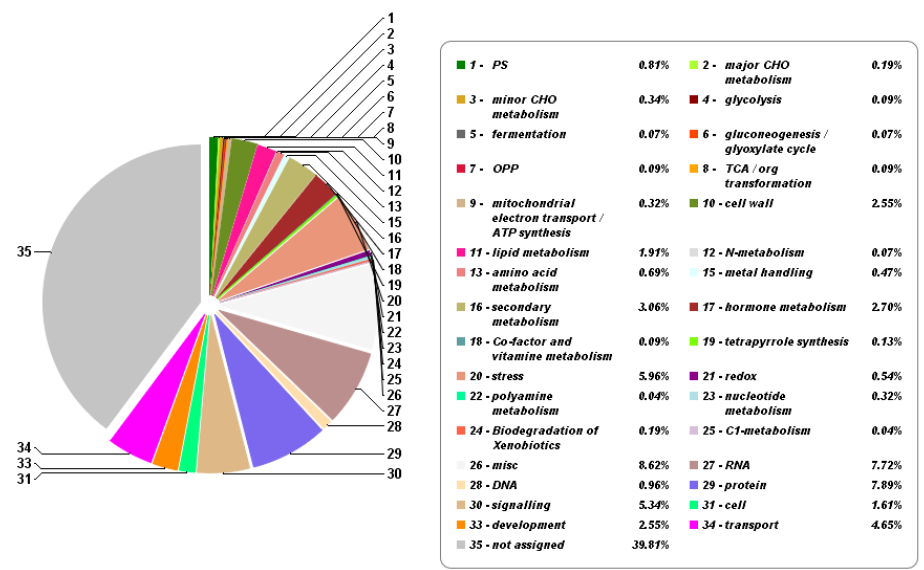
Figure 4. Functional categories of DEGs using MapMan 5.0 with default parameters. The numbers 1-34 in the pie chart represent different patyways. Detailed information on gene numbers and pathway names are also shown in Figure 4. Detailed DEGs annotation results of Table S4 have been provided in Table S5.